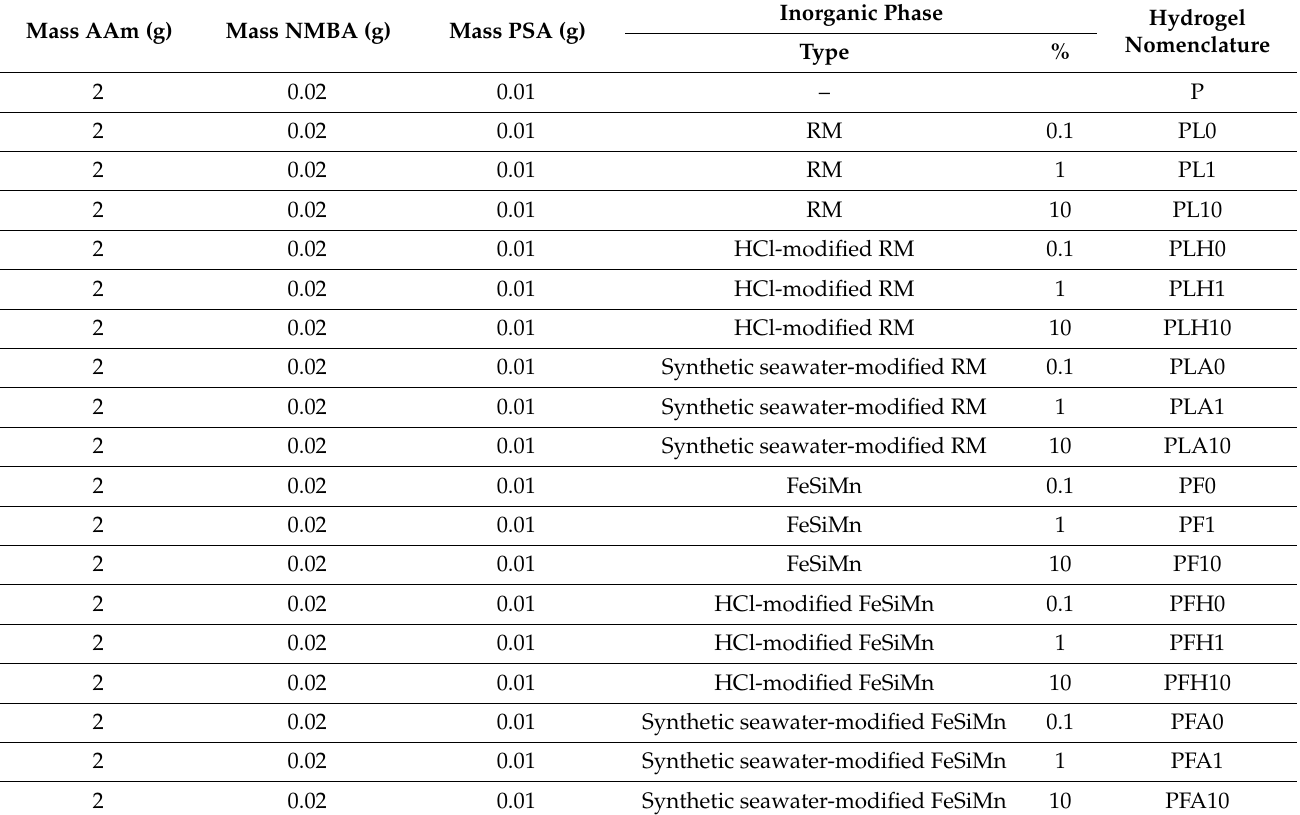
Table 2. Variables used in the synthesis and nomenclature used in the